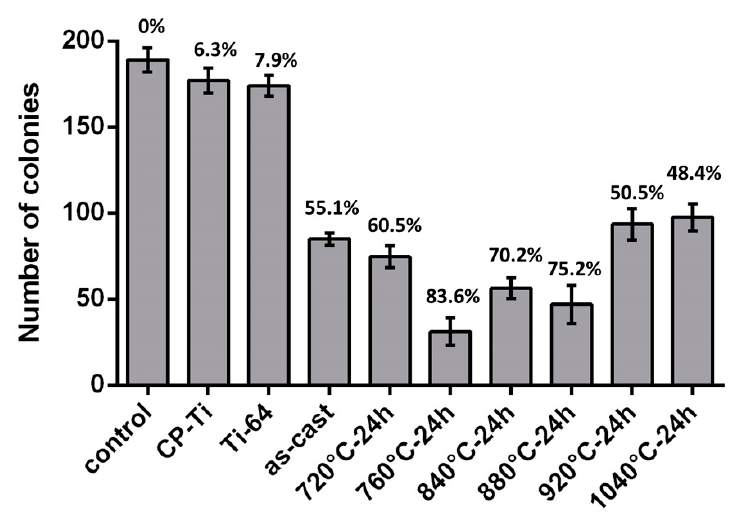
Figure 7. Numbers of bacterial colonies and the corresponding antibacterial properties (%) of the CP-Ti, Ti-64, and Ti-5Al-2.5Cu specimens annealed at various temperatures for 24 h.